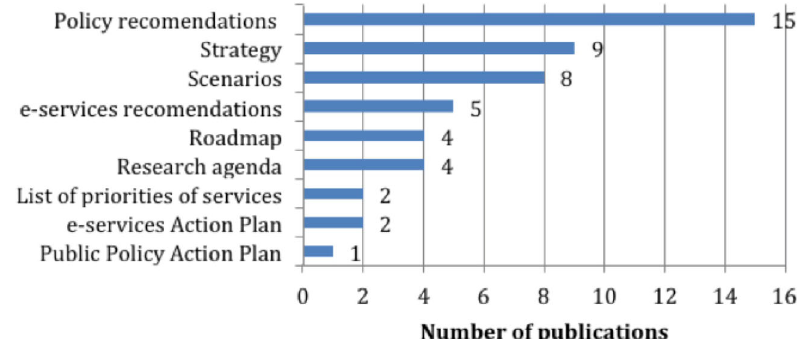
Fig. 8 Type of outputs